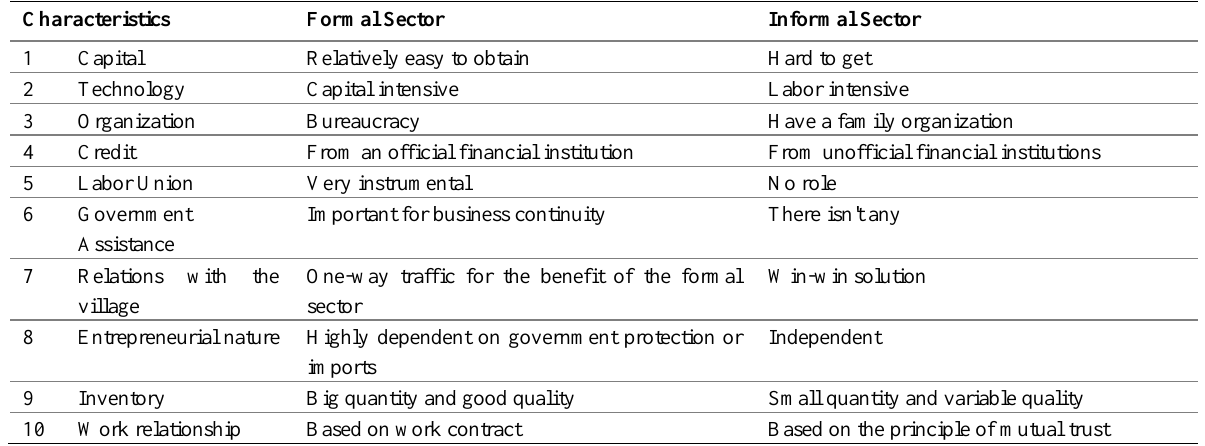
Table 2 : Differences in Characteristics Between the Formal and Informal